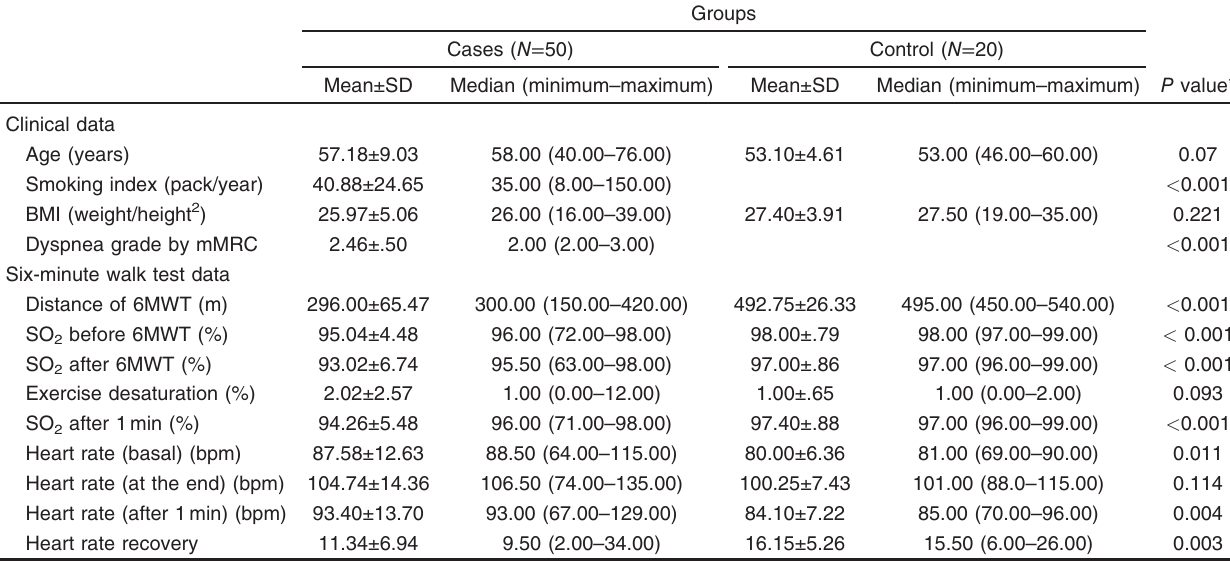
Table 1 Statistical analysis of the demographic data, clinical parameters among chronic obstructive pulmonary disease cases and control group